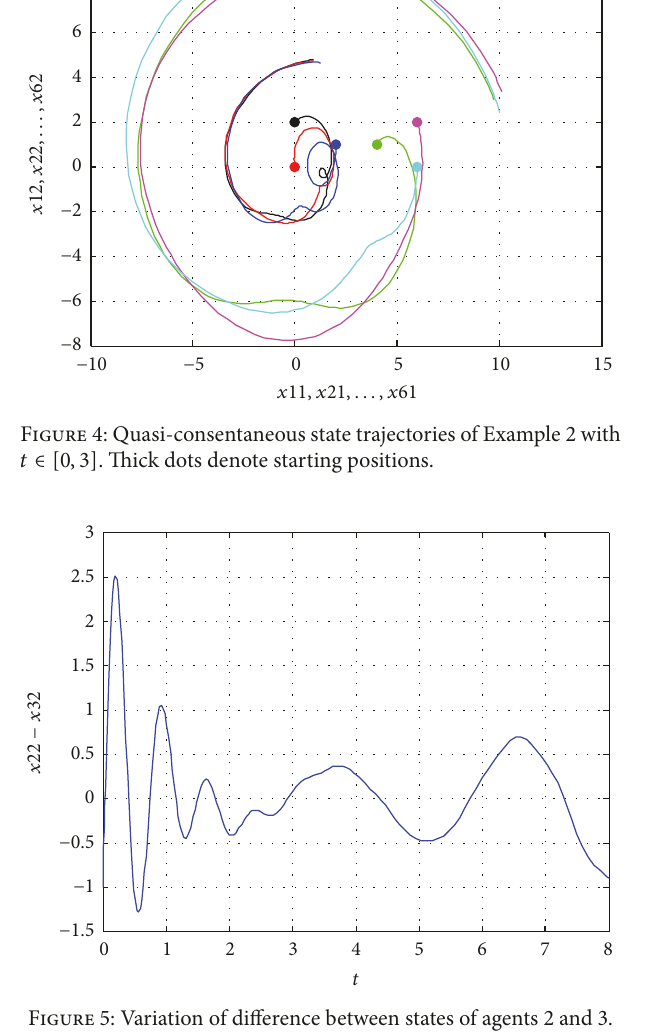
Figure 5: Variation of difference between states of agents 2 and